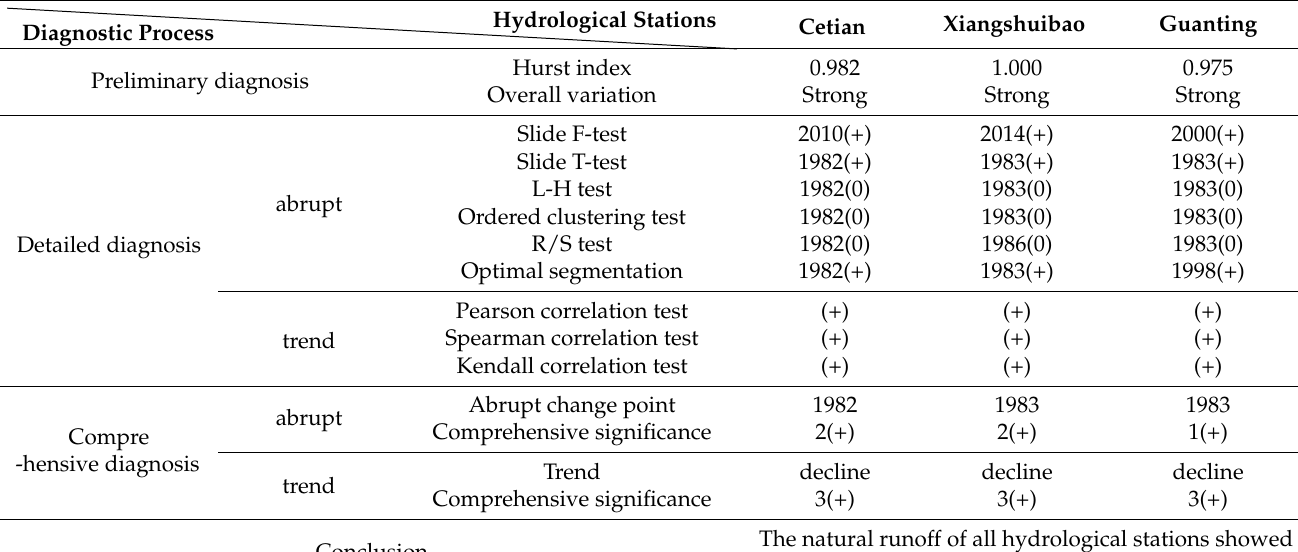
Table 1. Diagnostic results of annual natural runoff variation in the mountain area of Yongding River from 1956 to 2016. Hydrological Stations Cetian Diagnostic Process